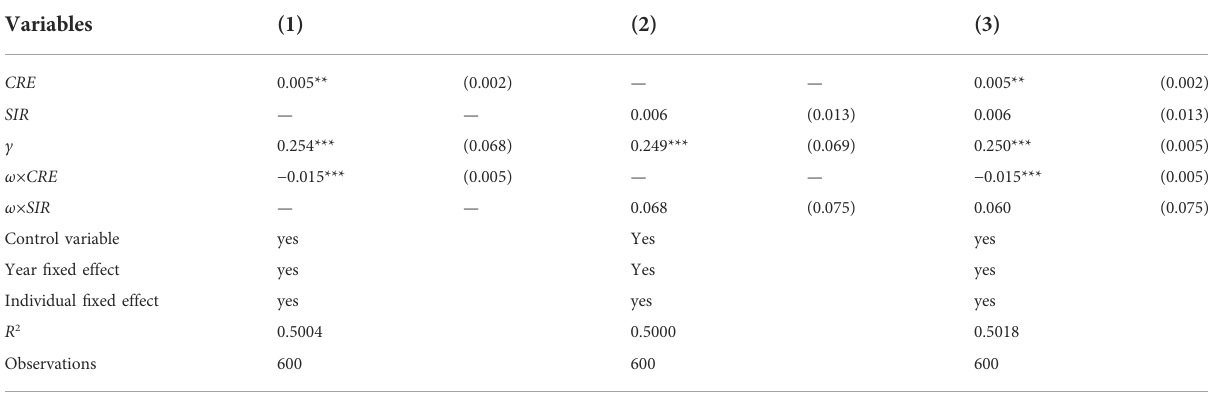
TABLE 4 The empirical results between FRAE and